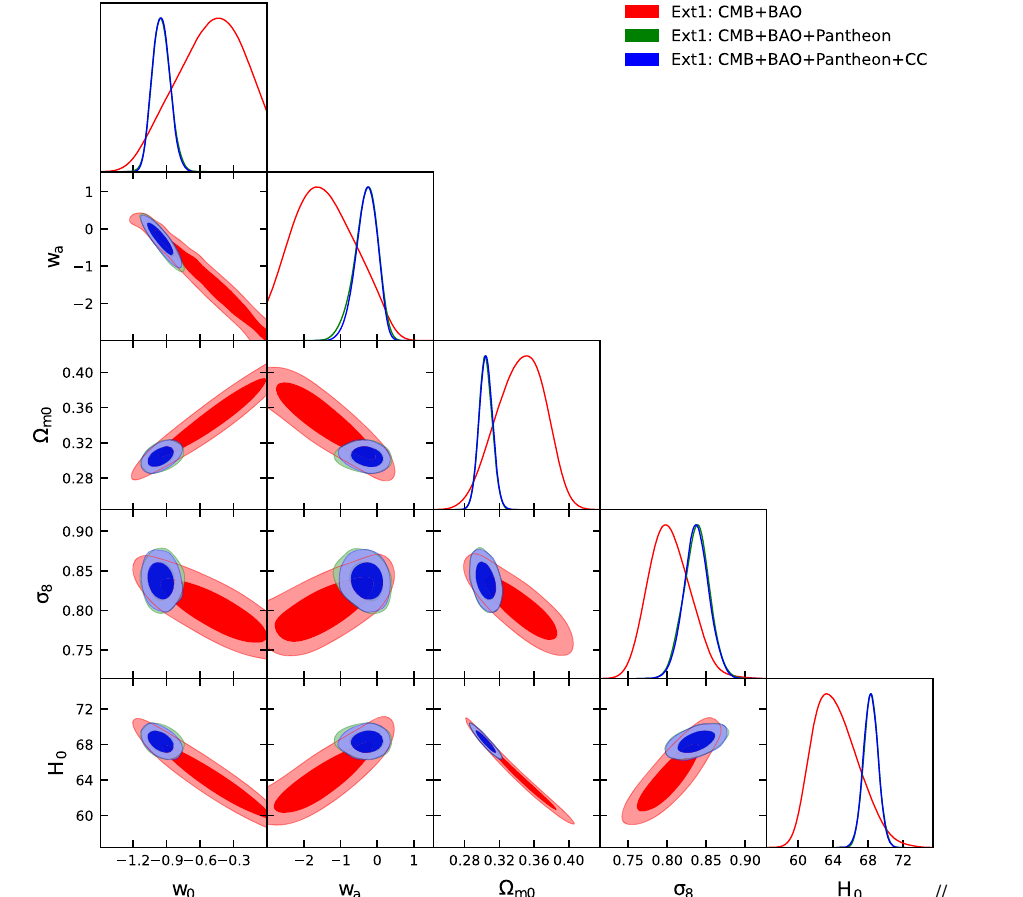
// contains the one dimensional marginalized posterior distributions for the parameters shown in the two dimensional contour plots